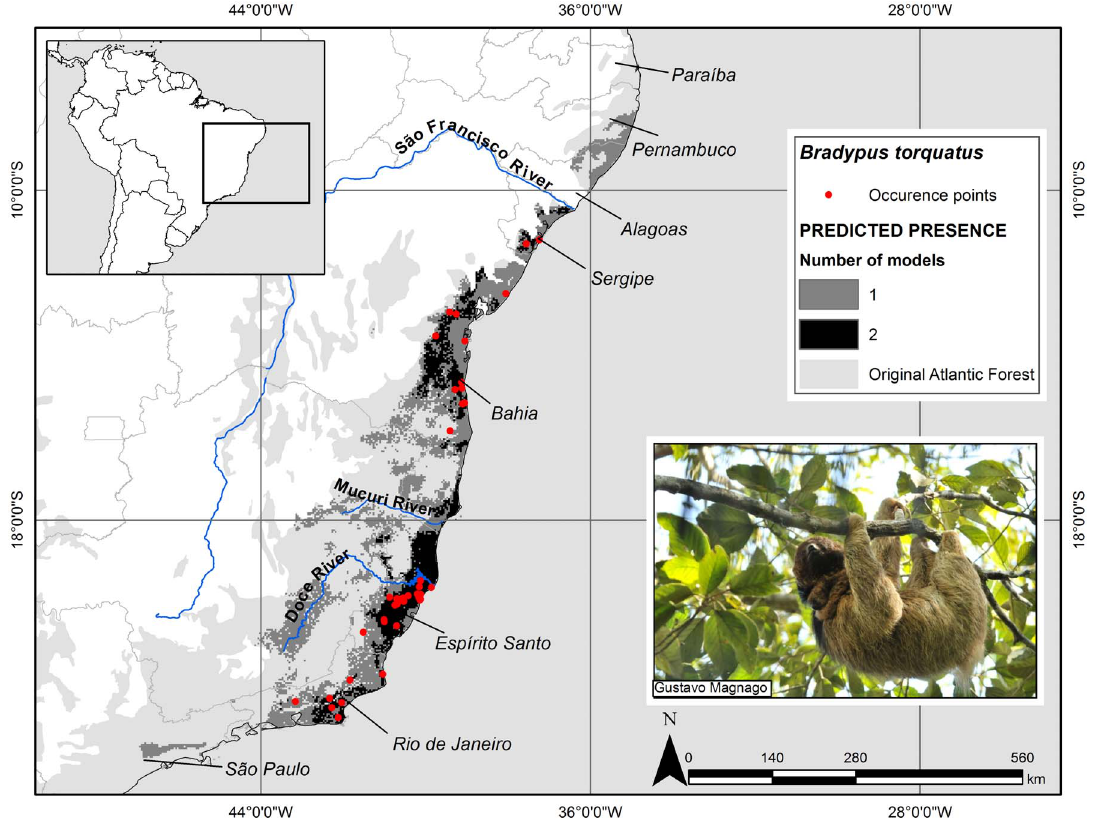
Figure 2. Potential geographic distribution of the maned sloth ( Bradypustorquatus ) in the Atlantic Forest. The potential geographic distribution of the maned sloth in the Atlantic Forest based on the binary ensemble model of Maxent and Mahalanobis Distance algorithm. The occurrence points used in the modeling are also shown in the map. Cartographic base: [79], Geographic Projection: Datum WGS 1984.